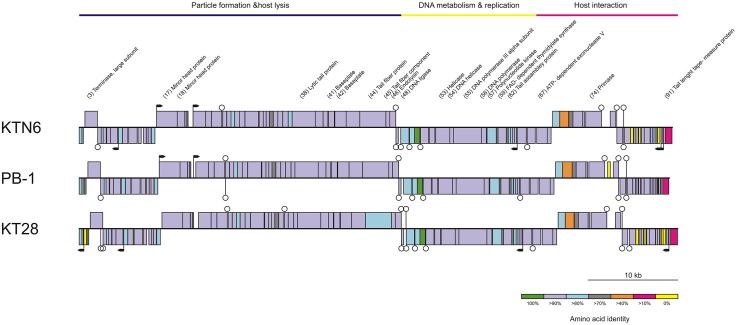

In silico analysis of KTN6 and KT28 phages and their comparison to PB1 phage. The predicted open reading frames of presented phages (rectangles) and their amino acid identity to the corresponding ORF in PB1 phage, indicated with different colors in the legend. Predicted terminators and promoters are shown as stem-loop structures and black arrows, respectively.